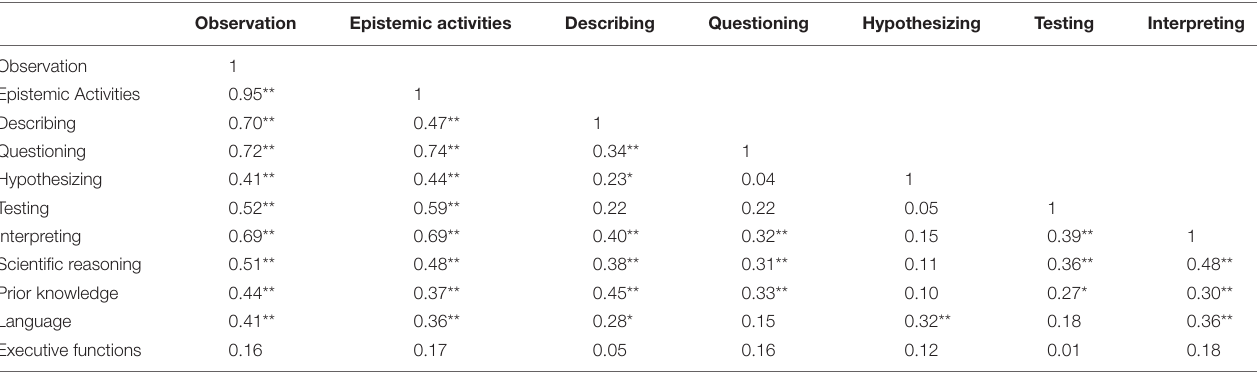
TABLE 8 | Intercorrelations among subscales and correlations with cognitive measures. Observation